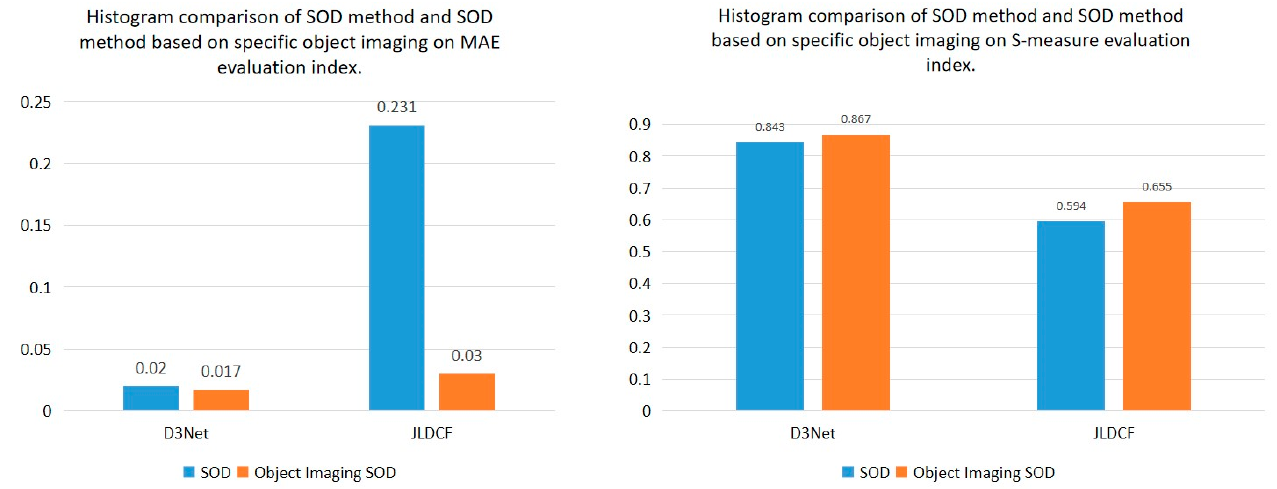
Figure 6. Comparison of the histograms of the SOD method and the SOD method, based on specific object imaging in the two evaluation indicators.